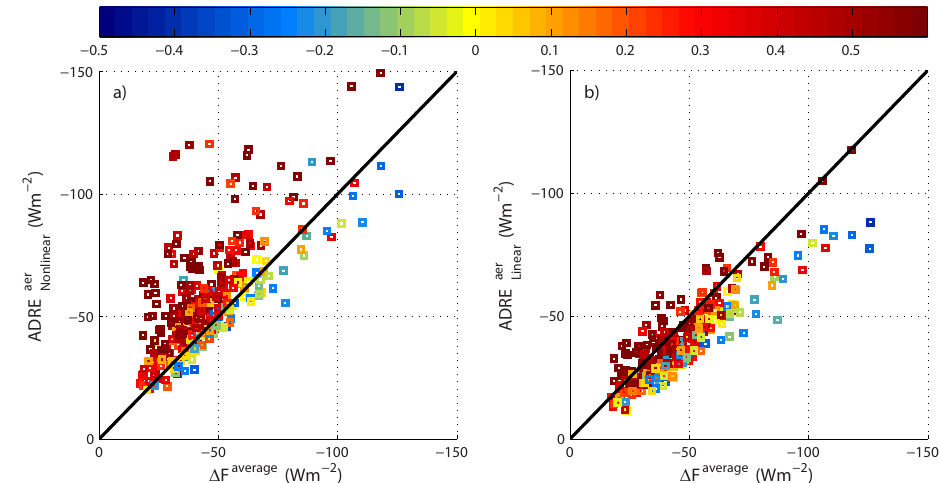
Figure 3. ADRE predicted with exponential decay (a) and linear (b) regression methods (Eq. 1), compared with AERONET values (Eq. 2). The color of the data points represents the correlation coefficient of the AOD and WVC correlation, with red color indicating positive and blue color negative